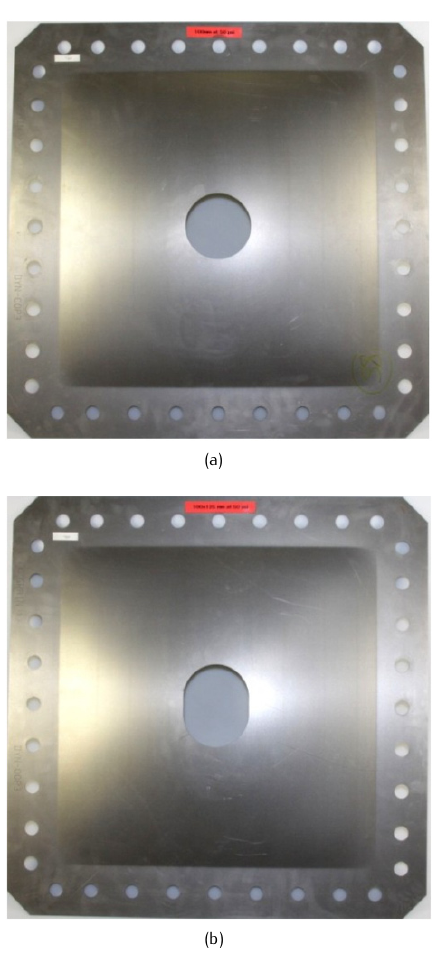
Figure 10. Deformed 0.5 m square plates with (a) φ 100 mm hole and (b) φ 100 by 125 mm hole showing plastic hinges at the edges and ∼ 21–22 mm permanent central deflection.